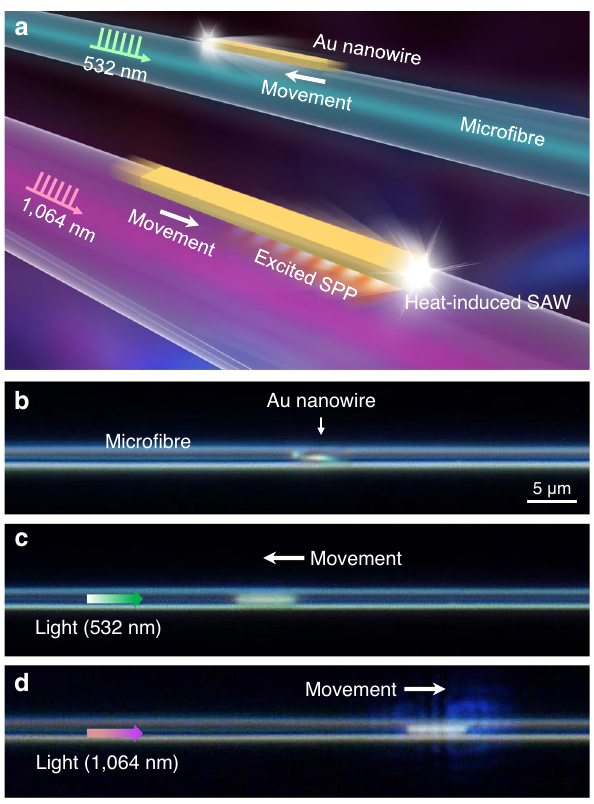
Fig. 1 Plasmon-driven movements of Au nanowires on silica micro fi bres. a Schematic showing movements of Au nanowires on suspended micro fi bres, driven by pulsed lasers with wavelengths of 532 and 1064 nm, respectively. Only the 1064 nm laser can ef fi ciently excite SPP in the Au nanowire, thus enhancing the heating effect of absorbed light and the induced SAW drive the Au nanowire to peristaltically crawl along the silica micro fi bre. b Microscope image of an Au nanowire ( L NW = 6.1 μ m) placed on a suspended micro fi bre ( D fi ber = 1.8 μ m). Note that the nanowire axis was not strictly parallel with the micro fi bre axis. c Under the 532 nm laser actuation from the left side, the Au nanowire moved to the left. d Under the 1064 nm laser actuation from the left side, the Au nanowire moved to the right. The used average power of the 532 and 1064 nm pulsed lasers was about 40 μ